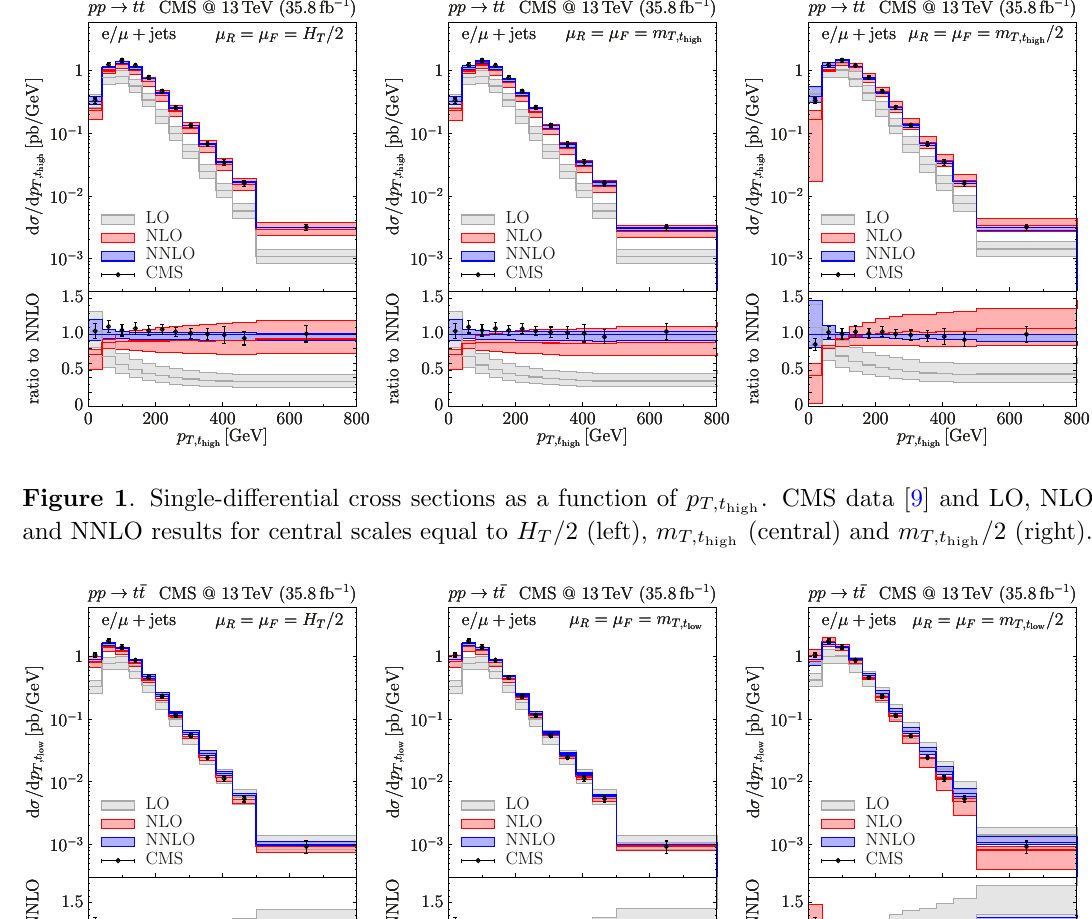
Figure 2 . Single-di(cid:11)erential cross sections as a function of p T;t and NNLO results for central scales equal to H T = 2 (left), m T;t ure 2 (central and right) we consider p T;t p T;t distribution is peaked at p T;t high at p T;t 60 low (cid:24)